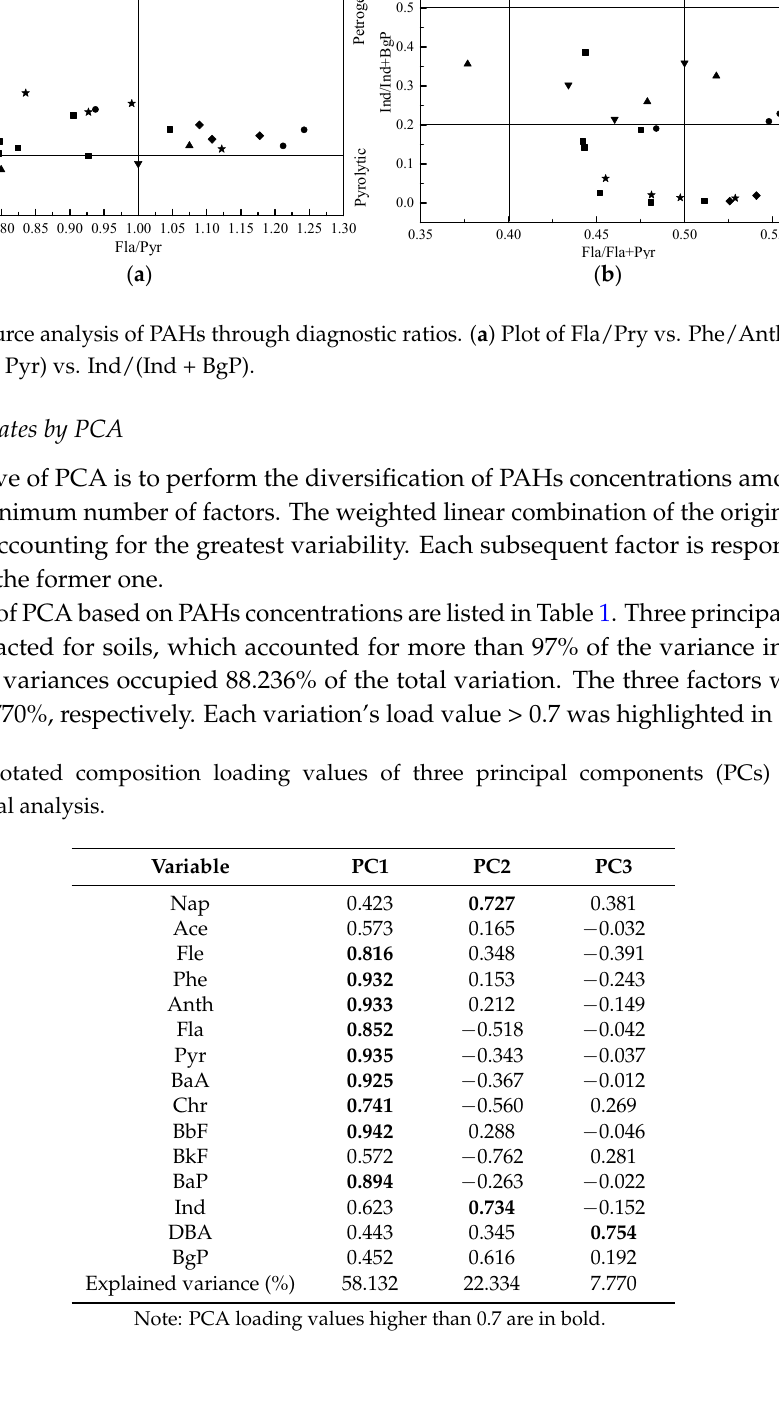
Note: PCA loading values higher than 0.7 are in bold.